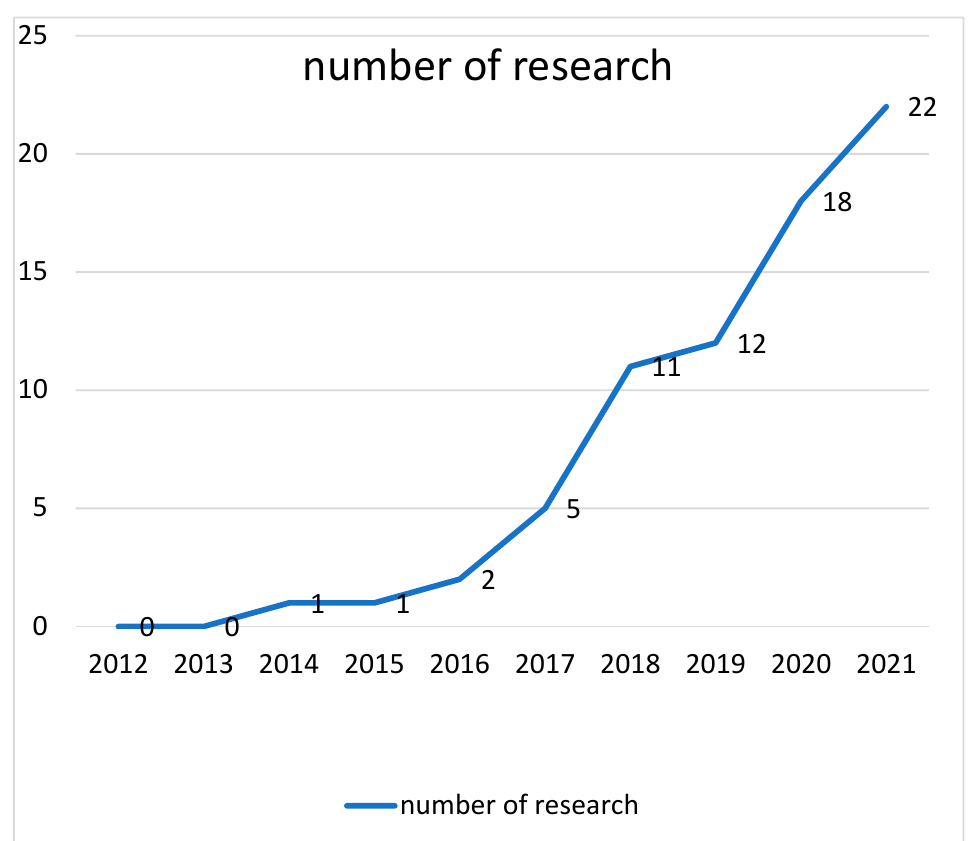
Figure 1. Number of studies on the use of 5G in smart cities (2012–2021) (by [8]).